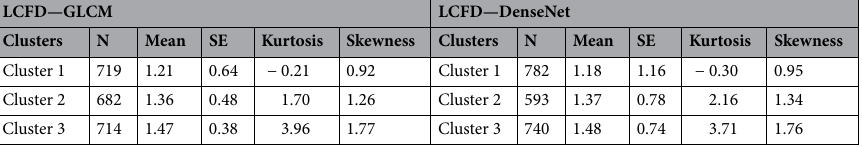
Table 1. Results of the LCFD histograms for clusters. CI confidence interval 95 % . N number of evaluated patches, SE standard